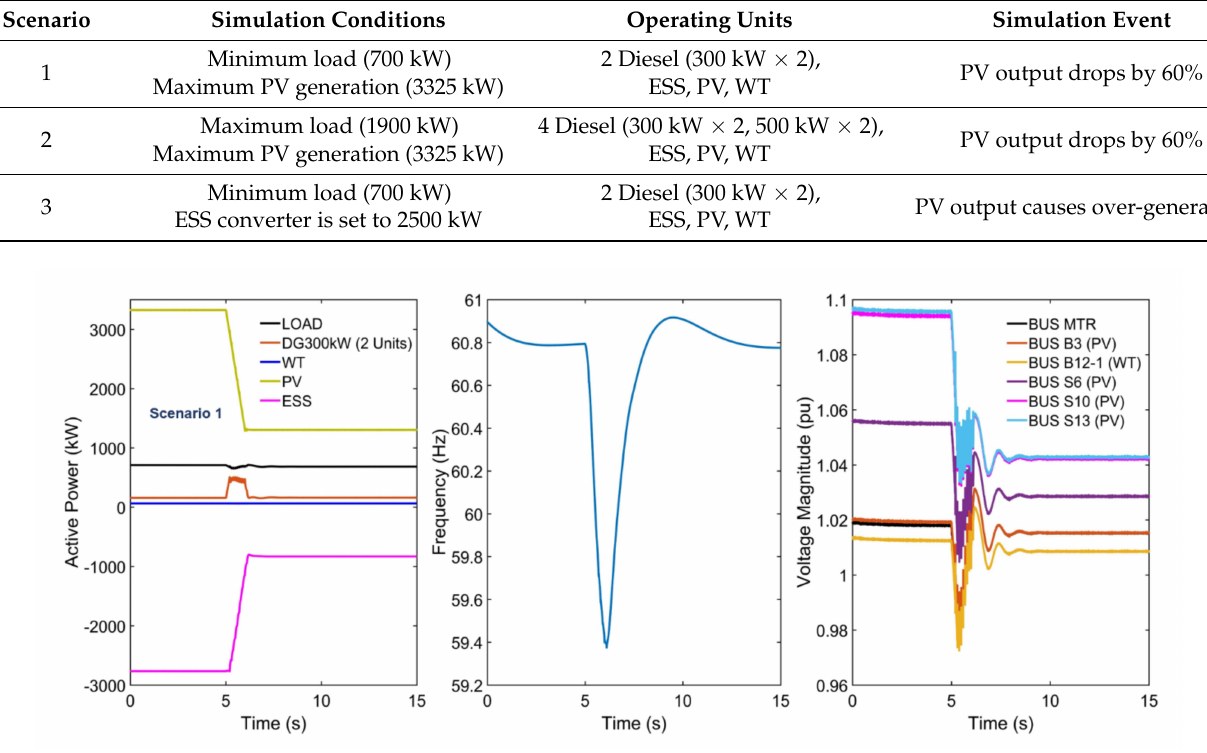
Figure 11. Active power, frequency, and voltage responses in Scenario